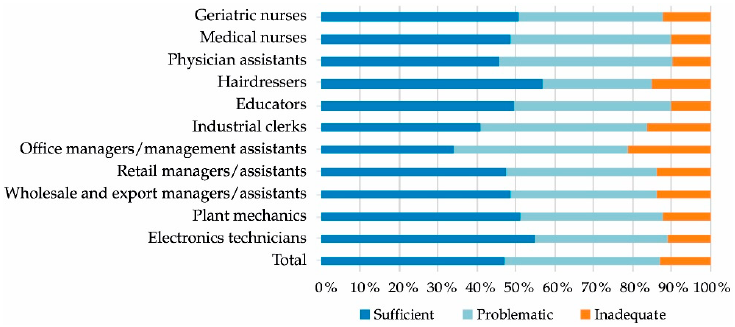
Figure 2. A sectoral comparison of health literacy ( n = 1754).